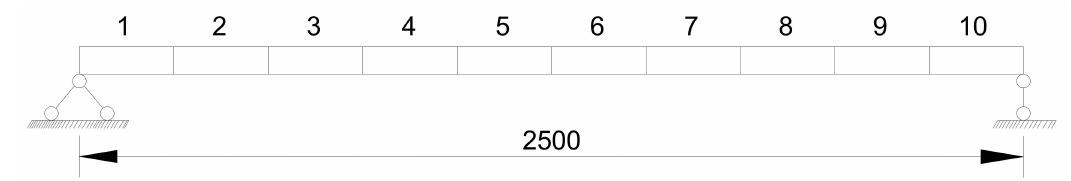
Figure 8. Finite element model of the simply supported beam.